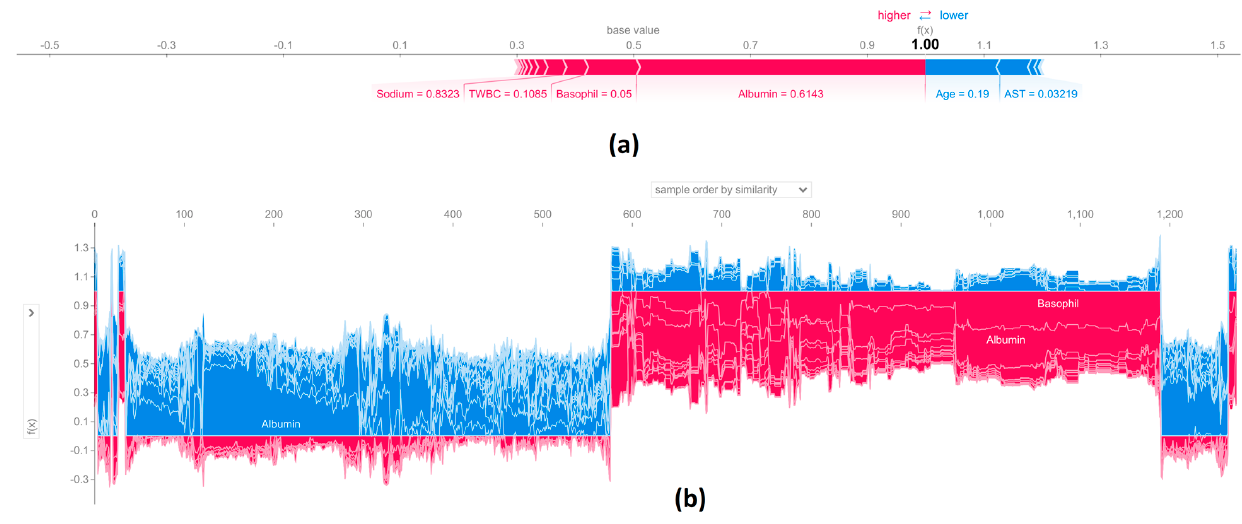
Figure 9. SHAP force plots for model explainability. ( a ) Force plot for a particular instance, ( b ) force plot for all instances.